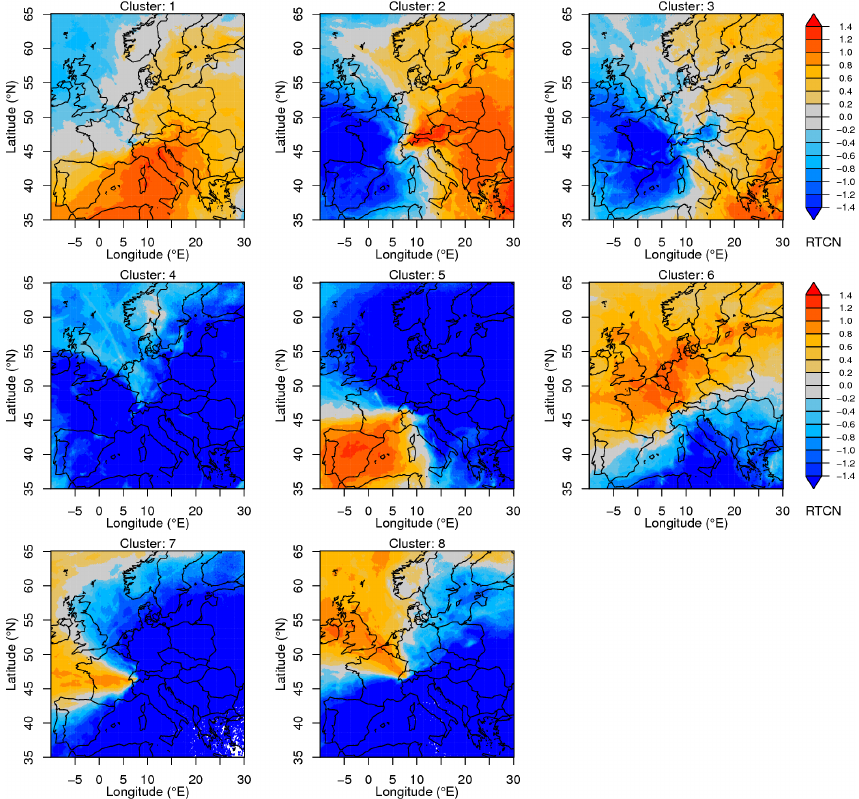
Fig. 9. Normalized residence time maps for different transport clusters for Jungfraujoch from January 2009 to April 2012 as obtained from FLEXPART simulations and footprint clustering. The color code indicates the cluster average source sensitivities at the surface relative to the overall footprint (RTCN: residence times by cluster normalized, see text for further